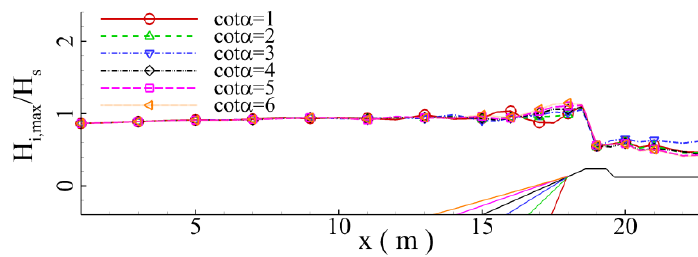
Figure 43. Space distributions of the local maximum wave height.